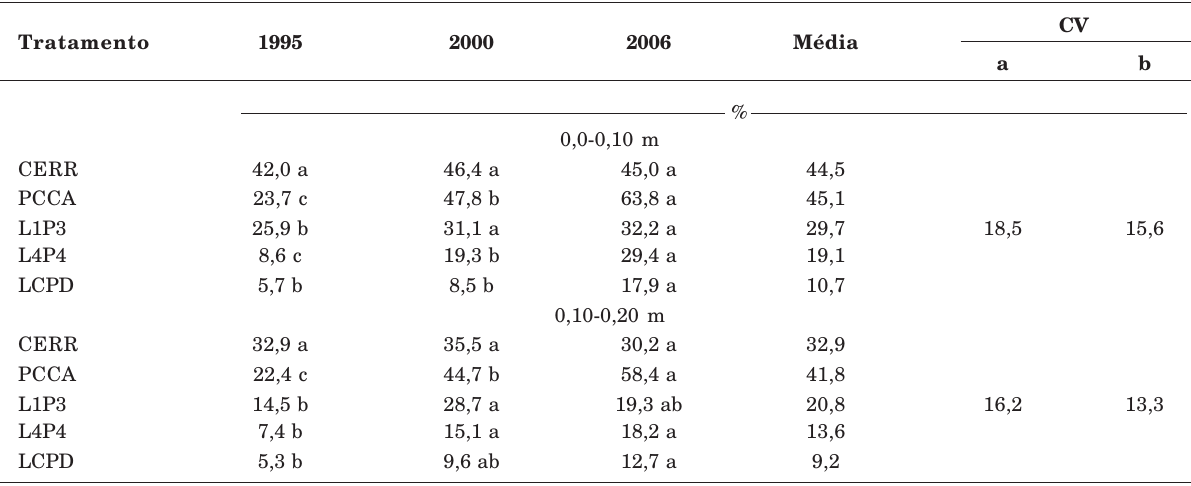
CERR: solo com vegetação natural; PCCA: solo com pastagem contínua e adubada; L1P3: solo sob lavoura de soja por um ano e por três anos com pastagem de Brachiaria brizantha ; L4P4: solo sob lavoura por quatro anos e por quatro anos com pastagem de Panicum maximum; e LCPD: solo com lavoura de soja em sistema de plantio direto. . CV: coeficiente de variação, (a) subparcelas (anos) e (b) parcelas (Tratamento). Letras iguais na linha não diferem entre si pelo teste de Tukey a 5